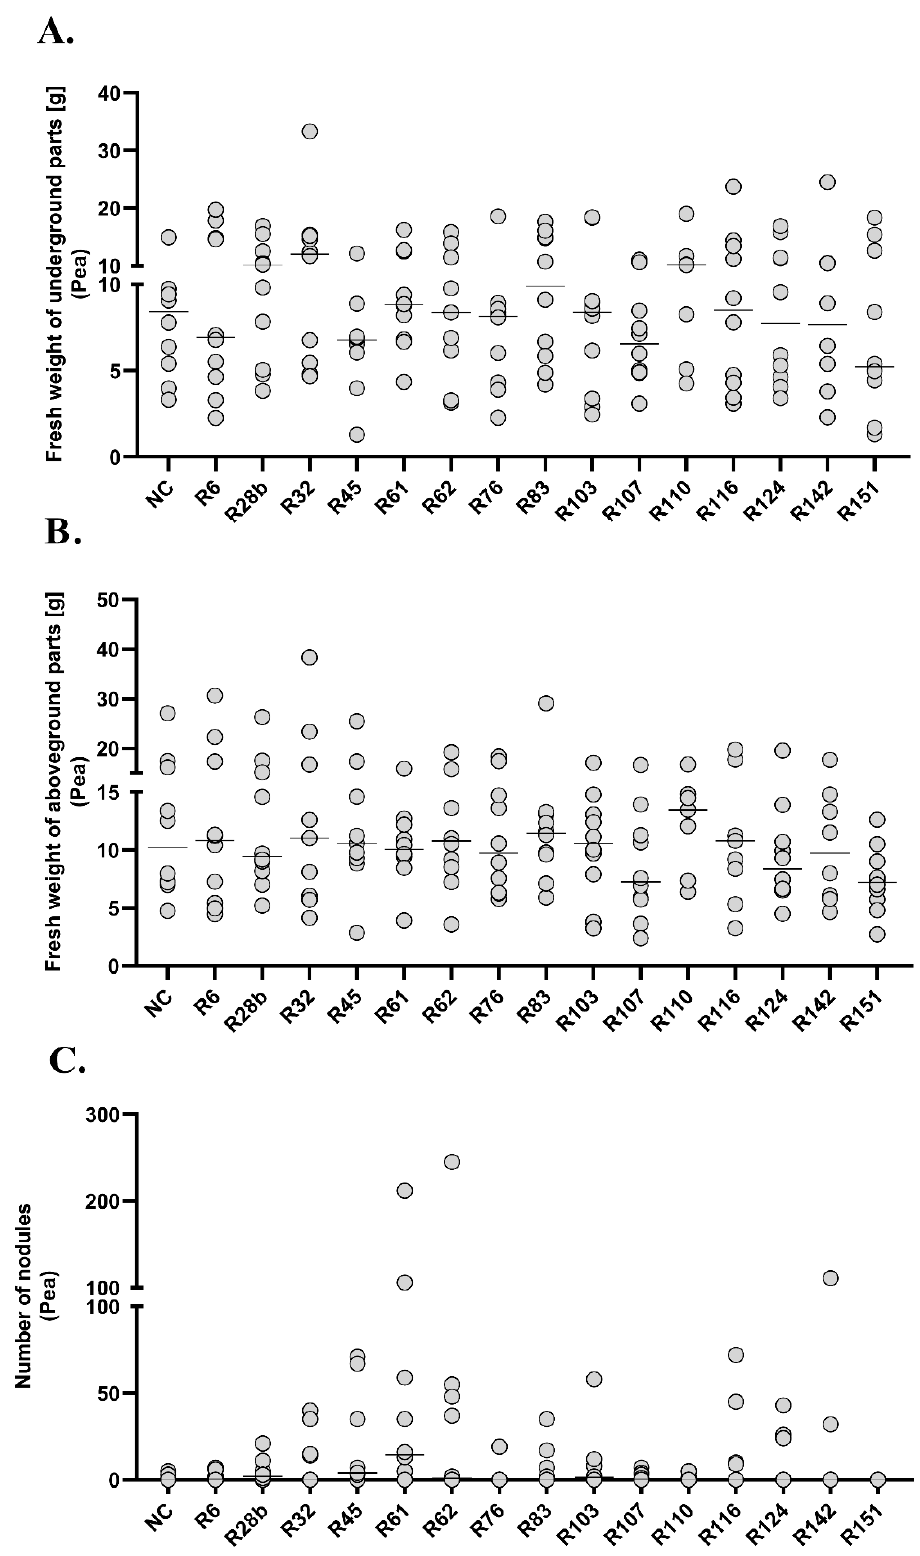
Figure 7. Fresh weight of underground ( A. ), aboveground ( B. ) parts and number of nodules ( C. ) in pea. The diagrams show the median of results in a particular group, n = 10.